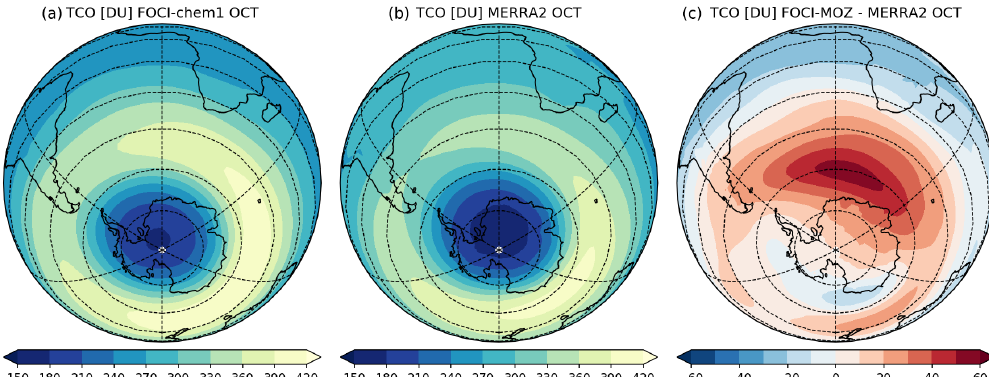
Figure A4. Mean TCO distribution in the SH in October in (a) the FOCI-chem1 simulation, (b) the MERRA2 reanalysis and (c) the differences between panels (a) and (b) from 1980 to 2013.